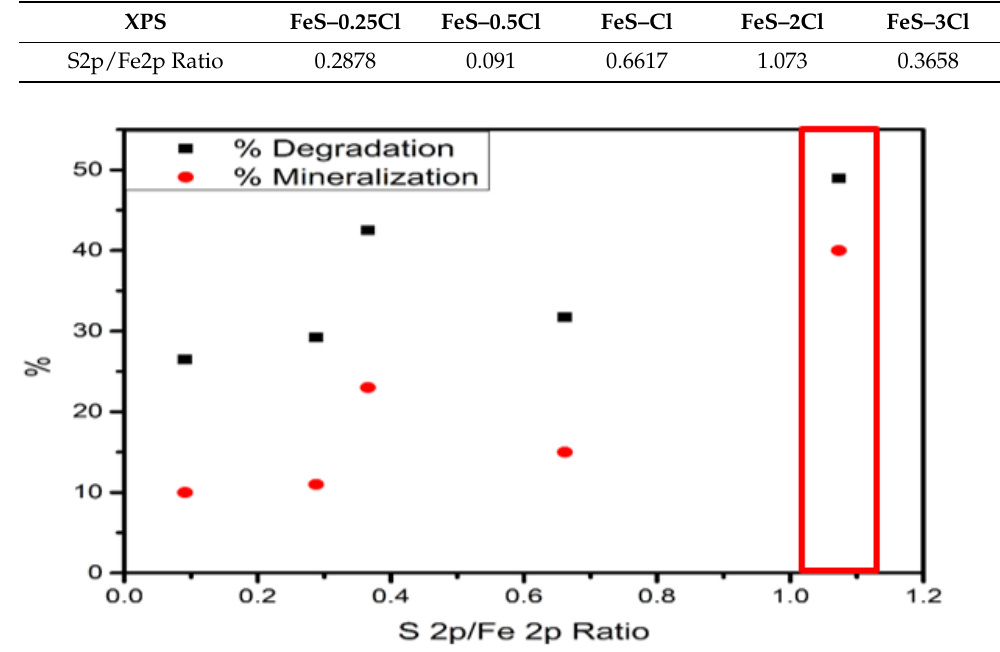
Figure 19. S2p/Fe2p vs. Degradation and Mineralization. Table 11. Oxide-band-gap to sulphide-band-gap ratio.